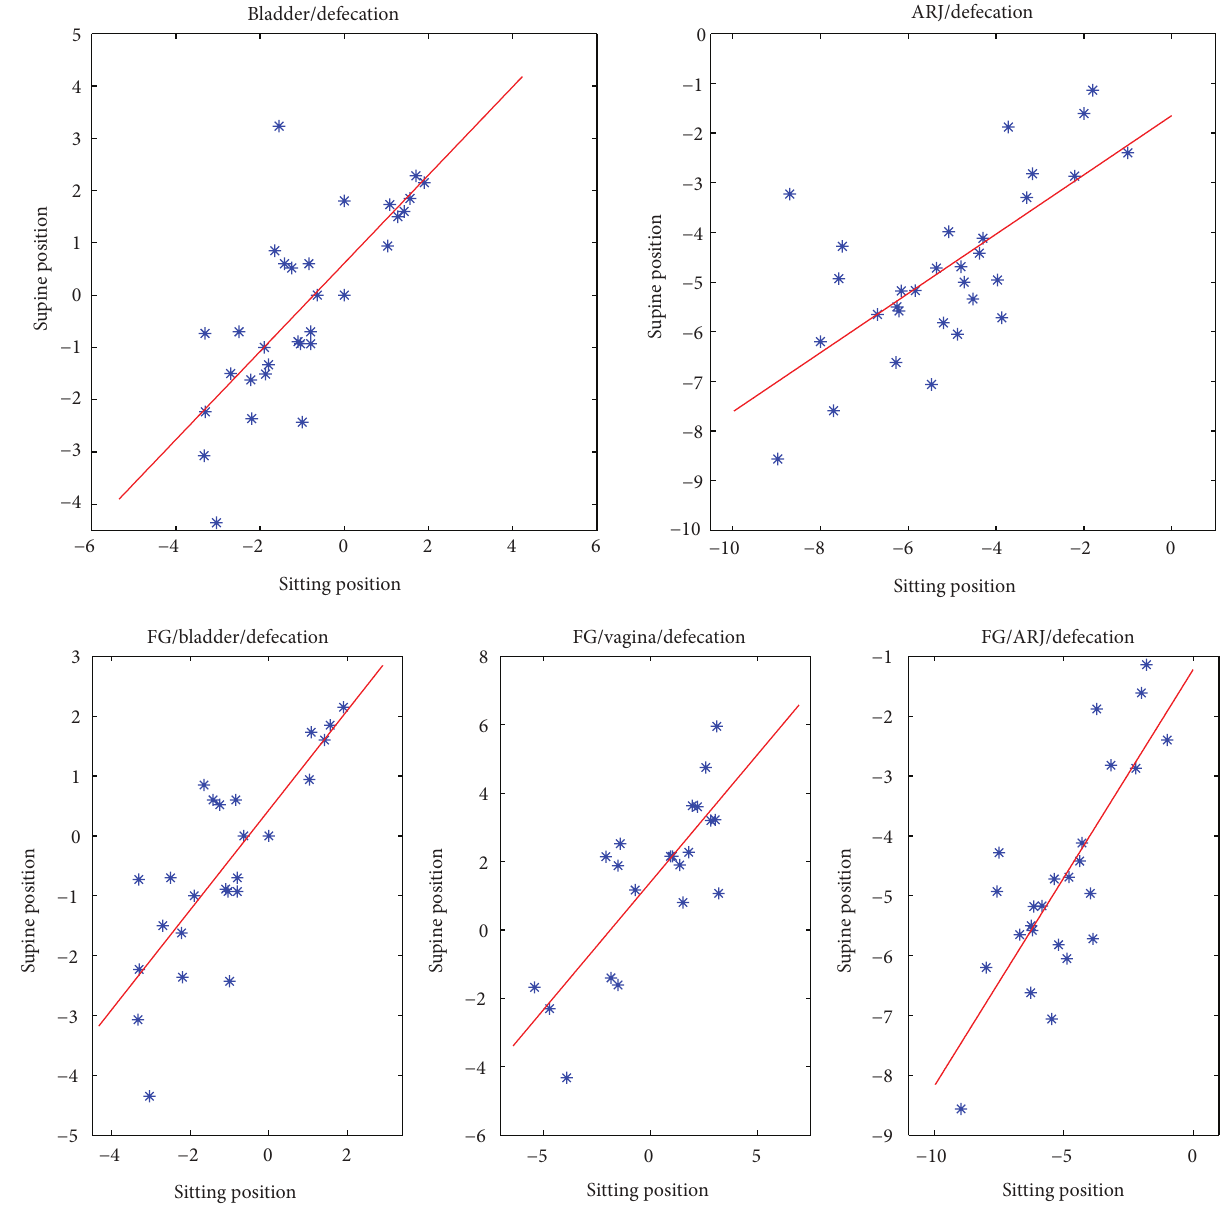
Figure 8: Linear correlation graphs of bladder and ARJ measures on all patients and of bladder, vagina, and ARJ measures on FG in defecation phase between sitting and supine